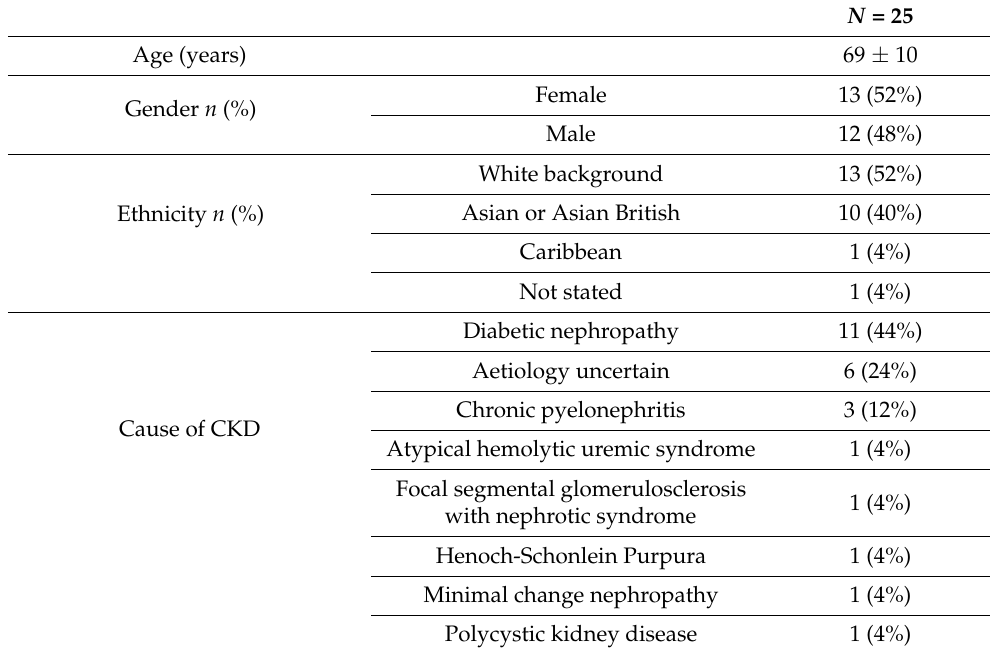
Table 1. Participant Demographics. Data are mean ± standard deviation or median (IQR) unless otherwise